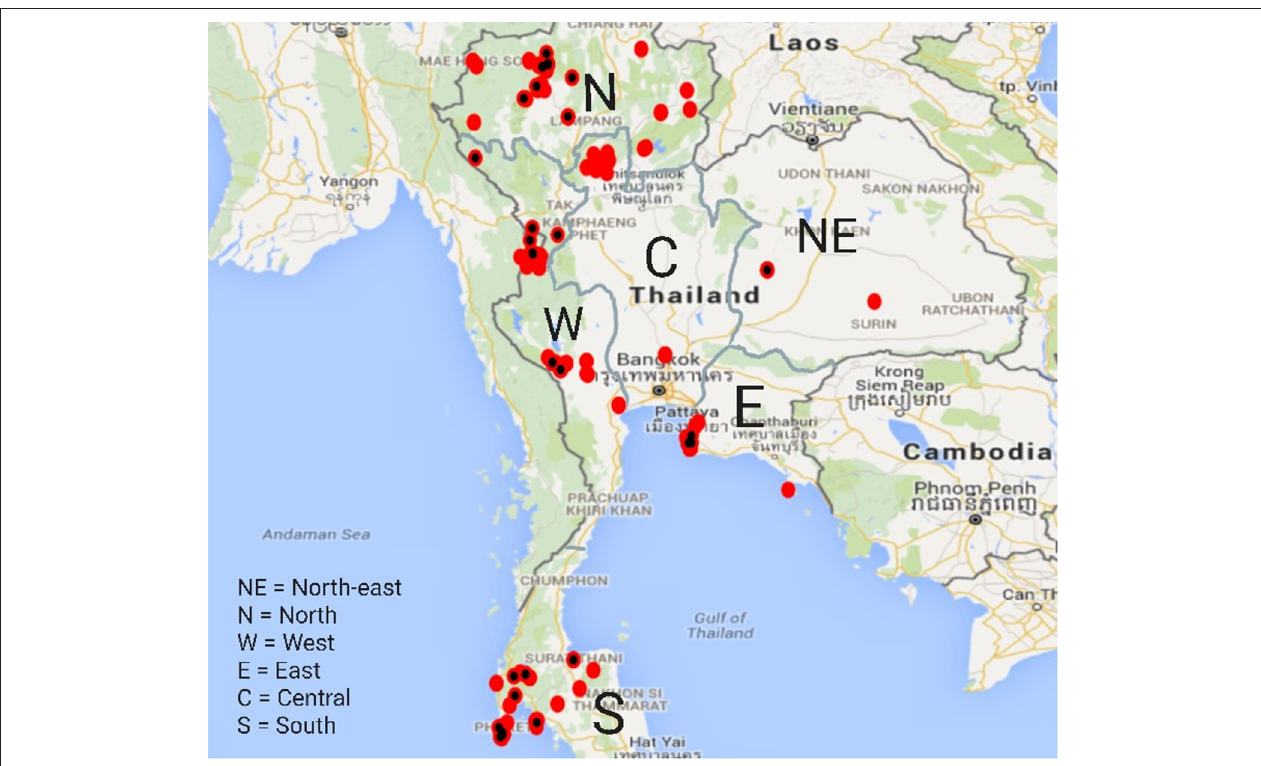
FIGURE 1 | Spatial distribution of elephants in the study across Thailand. Red dots marked with a black spot indicate presence of at least one elephant to be of the predicted positive TB serology test